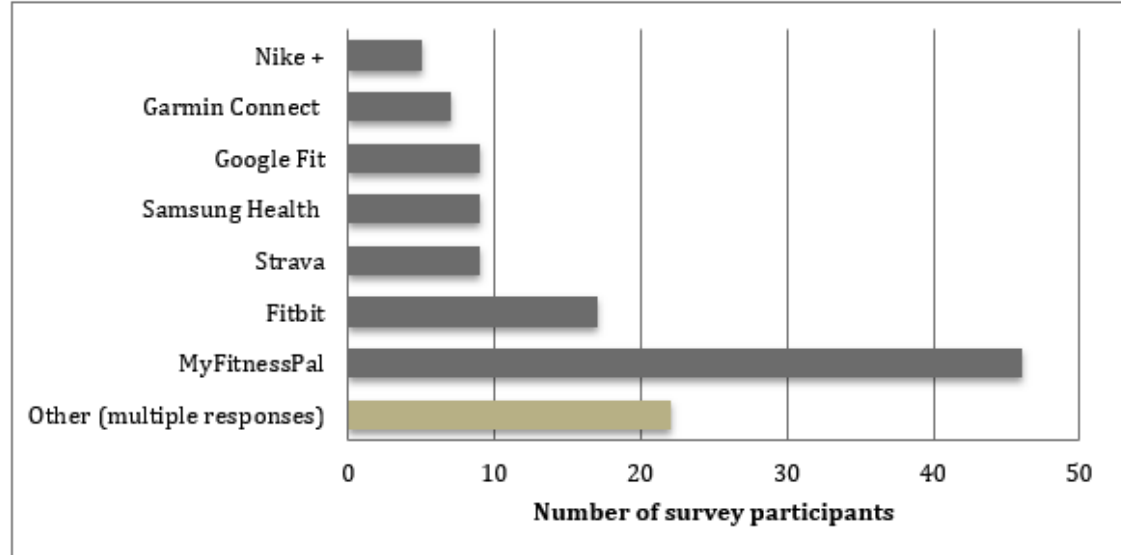
Figure 2. Healthy eating and fitness app use as reported by survey participants. The 7 most popular apps are used by between 5.2% and 48.4% of